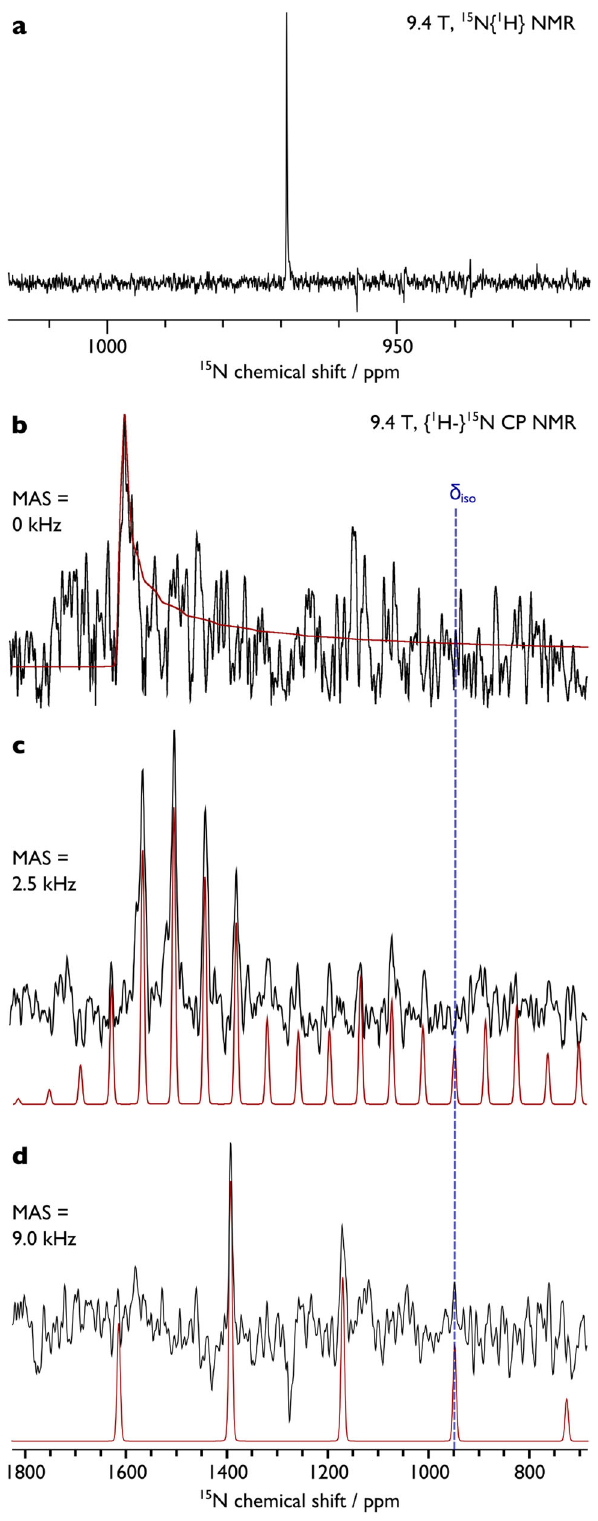
Fig. 2 15 N NMR spectra of 1* recorded at 298 K. a Solution spectrum in D 8 -THF. b Solid-state spectrum with MAS = 0 kHz. c Solid-state spectrum with MAS = 2.5 kHz. d Solid-state spectrum with MAS = 9.0 kHz. In each case the black line is the experimental spectrum, and the red line is the simulated